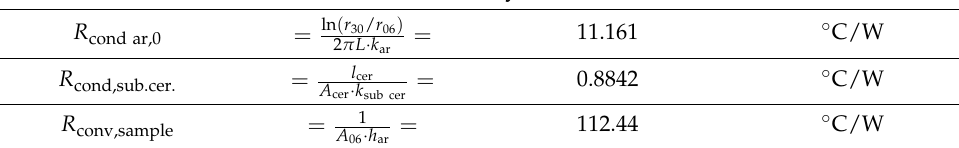
Table 3. Thermal resistances for the elements internal to the heating cylinder. Only the contributions of conduction and convection heat transfer were shown, specified by the subscripts cond and conv. Convection resistance refers to the upper face of the sample holder.